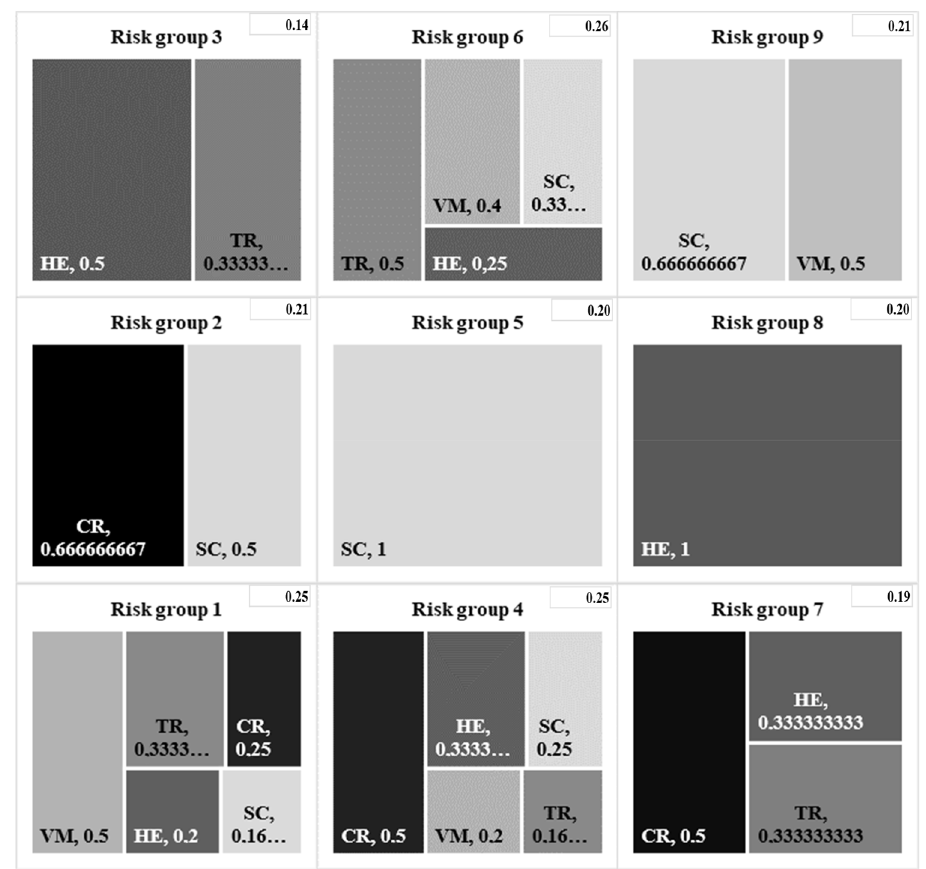
Figure 2. The risk map (source: compiled by